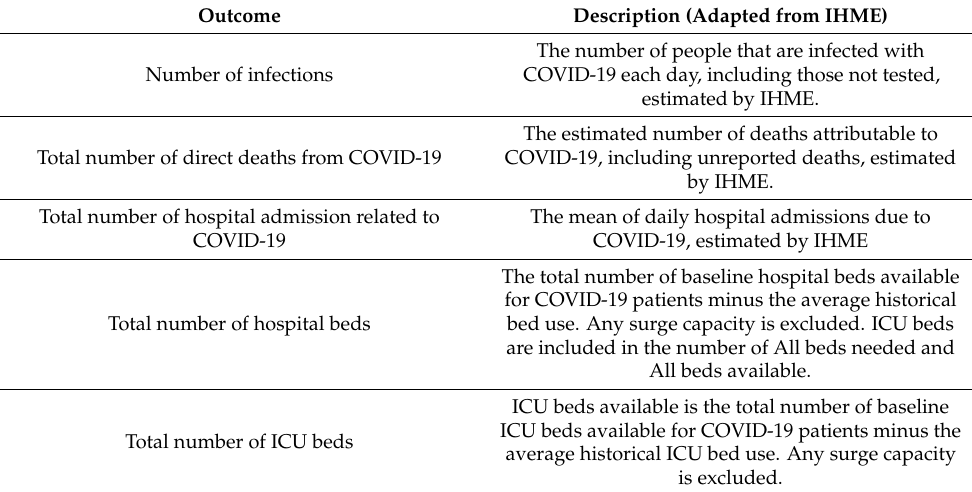
Table A3. Distribution of countries and population across country income groups.